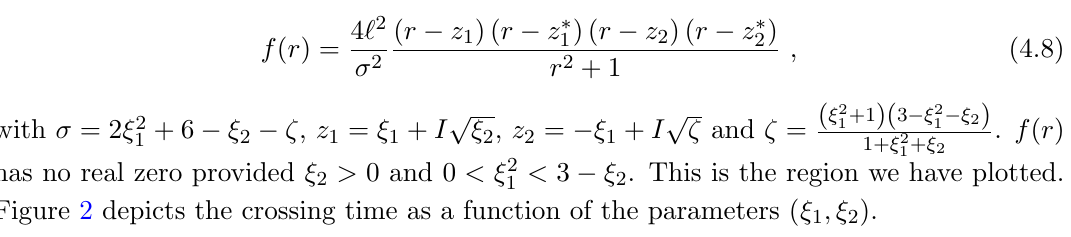
Figure 2 . Crossing time (cid:1) t as a function of the parameters 0 < (cid:24) 1 < red dot corresponds to m = 0 and (cid:27) = 4, i.e. global AdS 4 which does not represent a wormhole. (cid:1) t has a global minimum at that point ((cid:1) t min = 2 (cid:25) ). Outside of the AdS point the metric has two asymptotic regions and (cid:1) t is the time it takes to a photon to go from one asymptotic region to the other, as seen by a geodesic observer at r = 0 = (cid:18) . As suggested in the plot, if one approaches the boundaries of the domain on the plot ( (cid:24) 1 ; (cid:24) 2 ), (cid:1) t grows